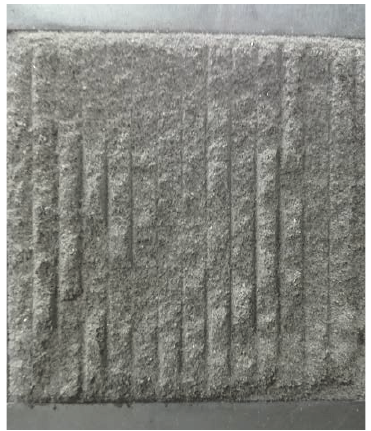
piles in soft rock. The homogeneous and isotropic simulated soft rock is manufactured into defined sizes and shapes readily with constant mechanical properties under laboratory